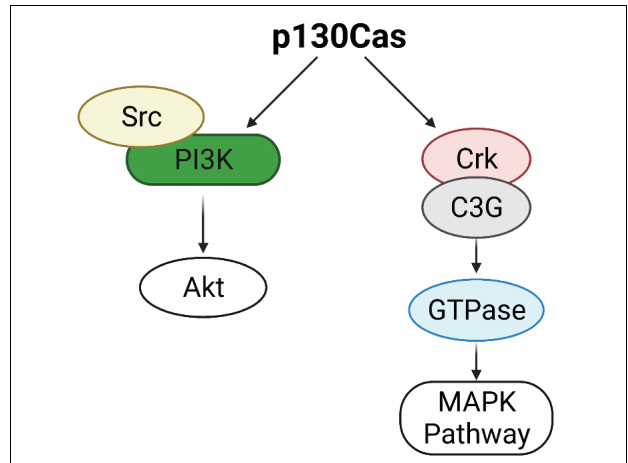
FIGURE 1 | Activation of Erk1/2 MAPK and Akt pathways by p130Cas. p130Cas may activate AKT through the Src/PI3K axis. p130Cas association with Crk and C3G induces GTPases activation, leading to the upregulation of the MAPK pathway.